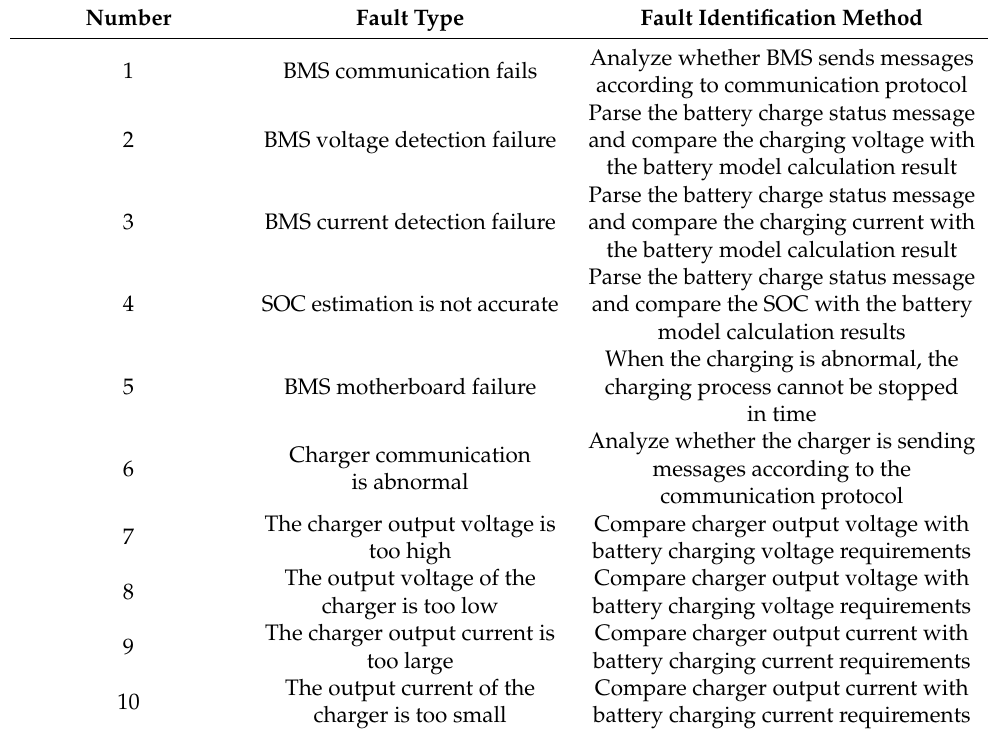
Table 5. Identifiable fault